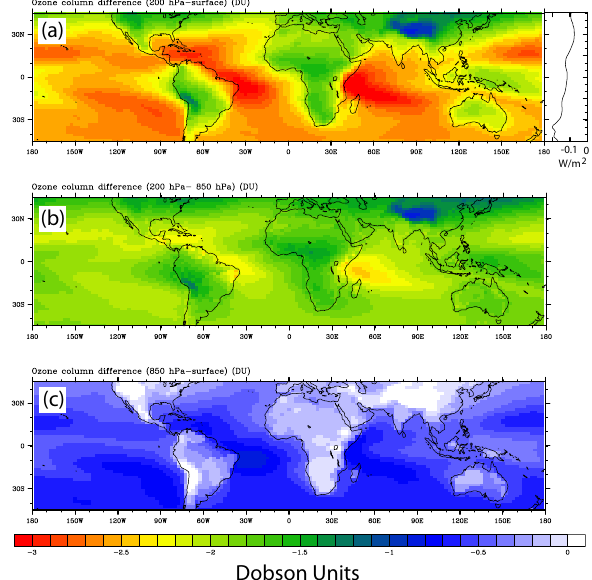
Fig. 7. Ozone column difference resulting from including tropo- spheric halogen chemistry in CAM-Chem for (a) 200hPa-surface, (b) 200–850hPa, and (c) 850hPa-surface. The latitudinal depen- dence of the perturbation of the radiation flux at the tropopause as- sociated with the tropospheric ozone column loss is shown on the right-hand side of the upper